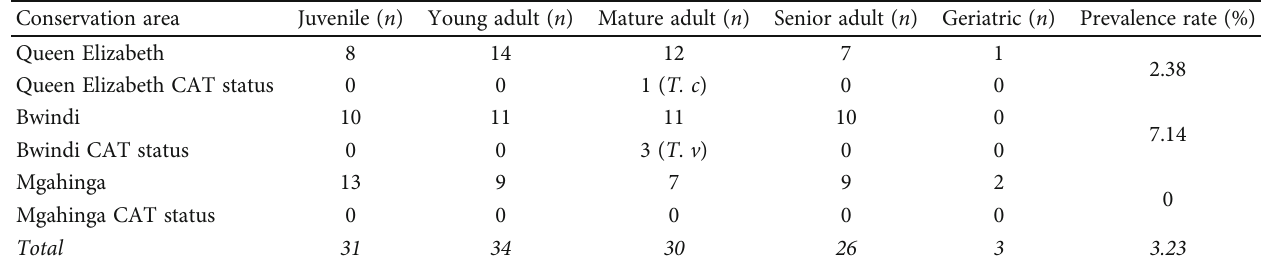
Key: n : number of dogs sampled; T . c : T . congolense ; T . v : T . vivax .